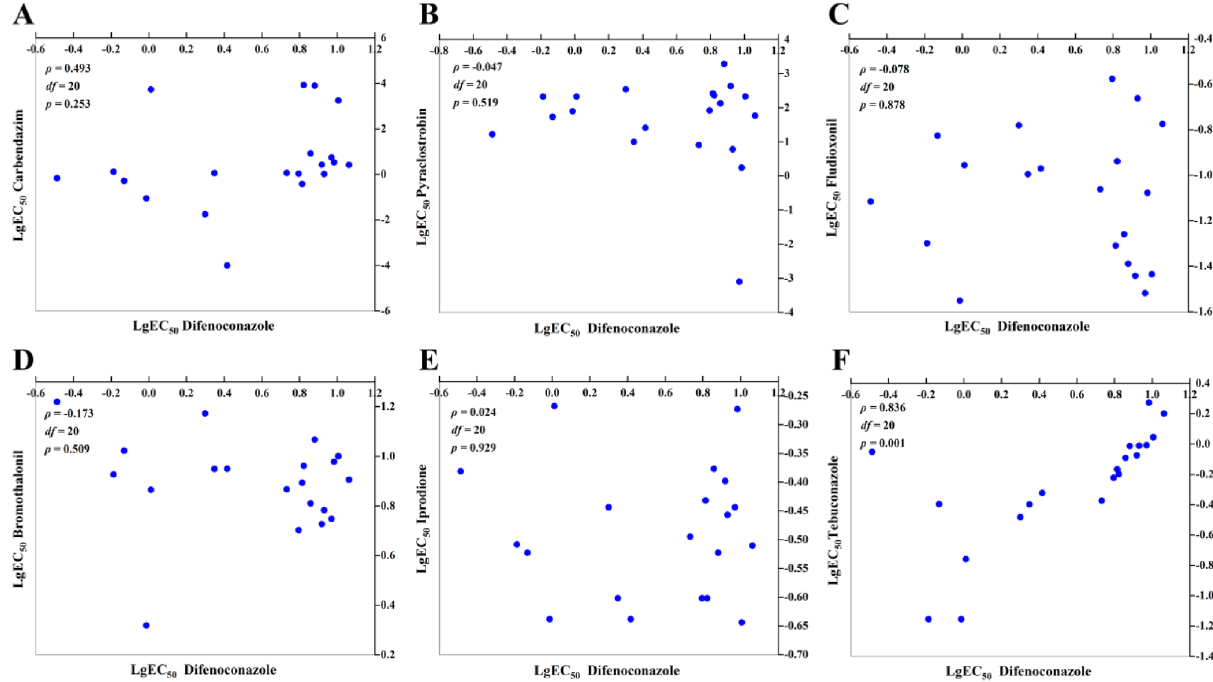
Figure 3. Cross-resistance between difenoconazole and carbendazim ( A ), pyraclostrobin ( B ), fludioxonil ( C ), bromothalonil ( D ), iprodione ( E ), tebuconazole ( F ) by rank correlation analysis. Data shown in logarithmic values of EC 50 among Lasiodiplodia theobromae for fungicide